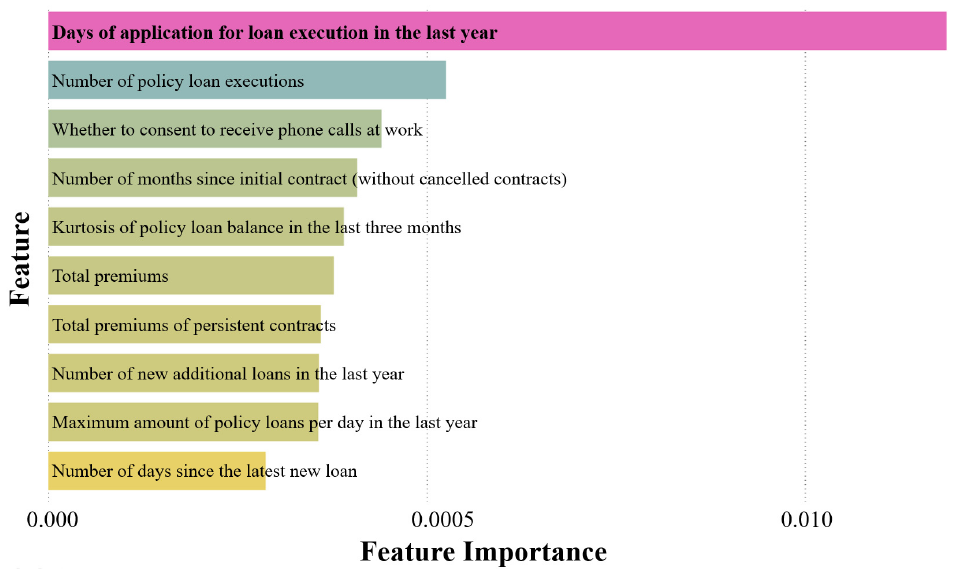
Figure 6. Top 10 important features in machine learning models.